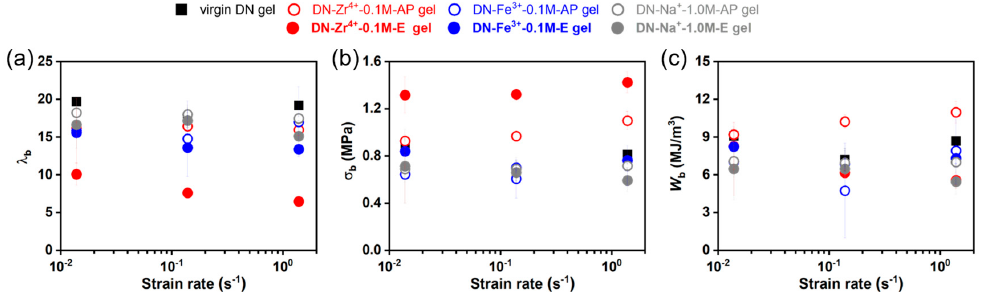
Figure 10. ( a – c ) Dependence of the stretch ratio at break λ b ( a ), the stress at break σ b ( b ), and work of extension W b ( c ) on strain rate for various DN